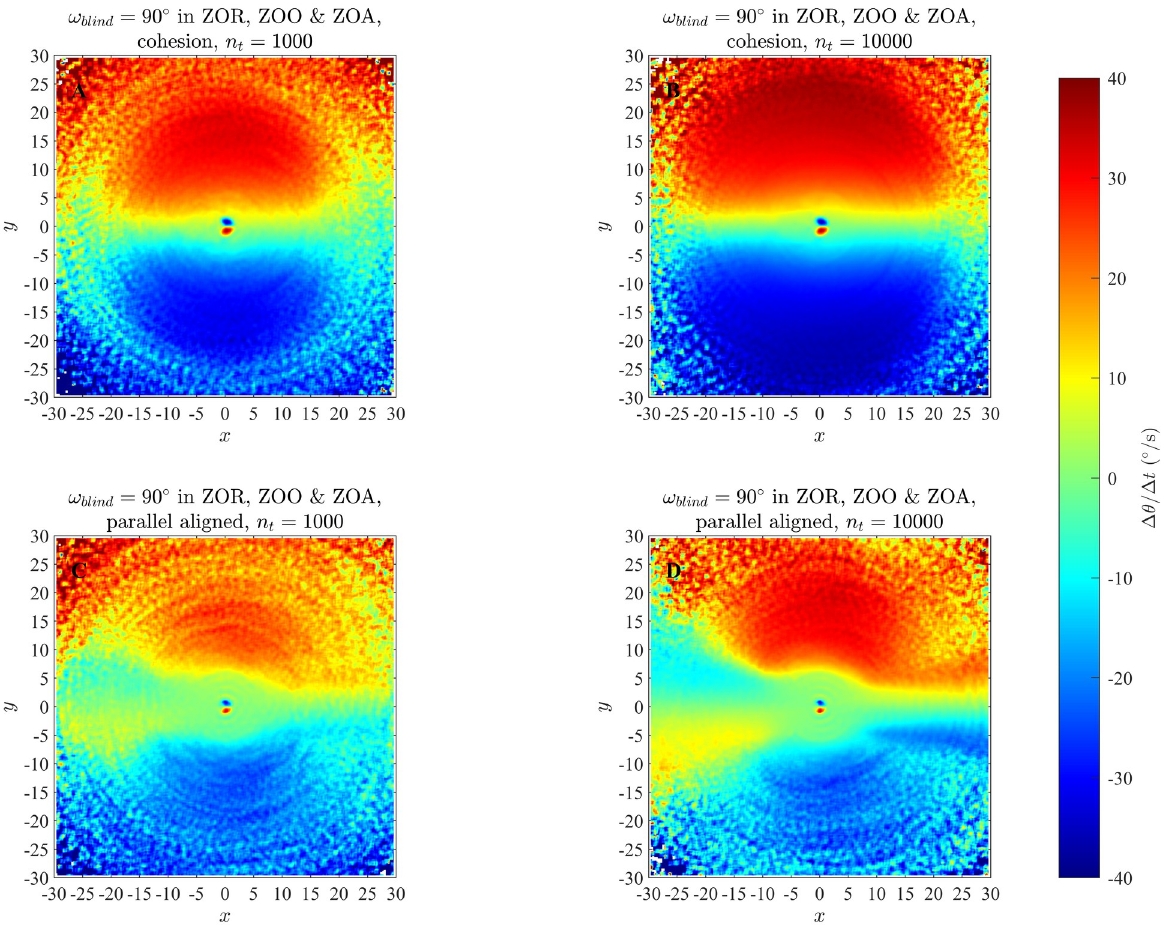
Fig 5. A comparison of analyses of simulations run for 1000 time steps (left column) and 10000 time steps (right column) for groups that exhibited cohesion without parallel motion (top row) or formed into aligned groups (bottom row) when r from simulations with N = 25